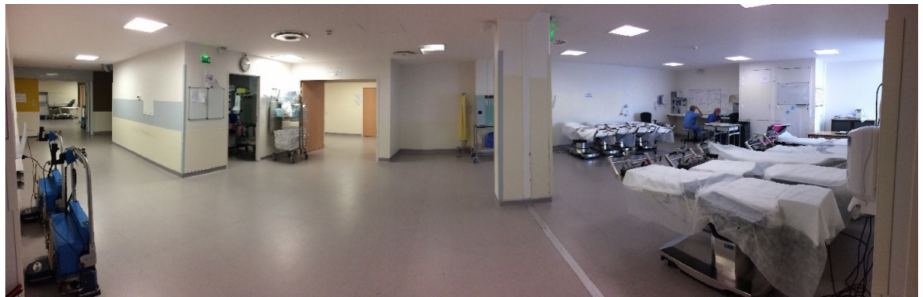
Figure A1. Picture of a surgical transfer and waiting area. Patients arrive from the floor (left), received by a paramedical staff and transferred to the surgical tables (right, far corner), and are then dispatched to the ORs (exit, center). The PACU entrance/exist is just behind the central